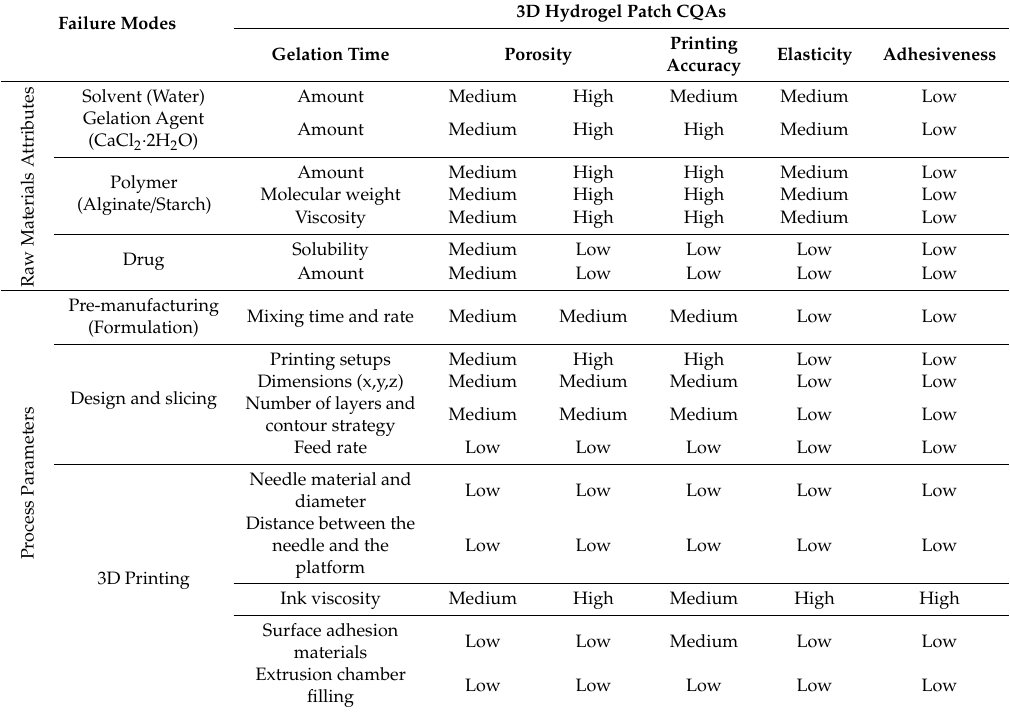
Table 2. Risk Estimation Matrix (REM) presenting initial risk assessment levels of ionic cross-linked alginate-starch 3D patches for topical application, including formulation and process parameters. Low, low risk parameter; Medium, medium risk parameter; High, High risk